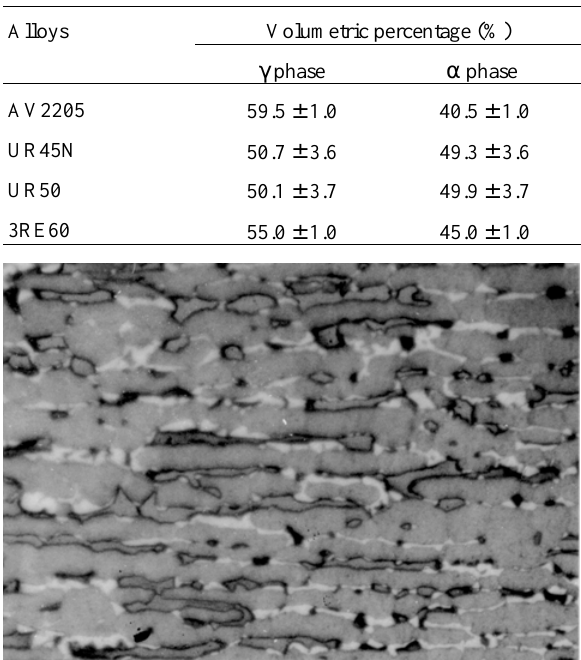
Table 2. The volumetric percentages of γ and α phases in the solution annealed